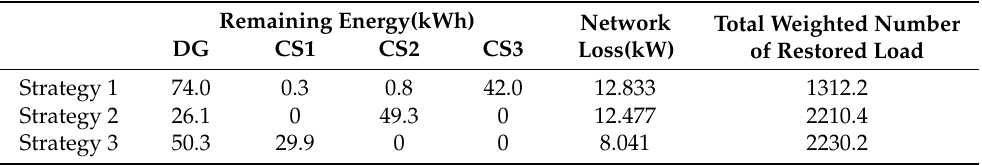
Table 4. Comparison of the load restoration effects of the three strategies.